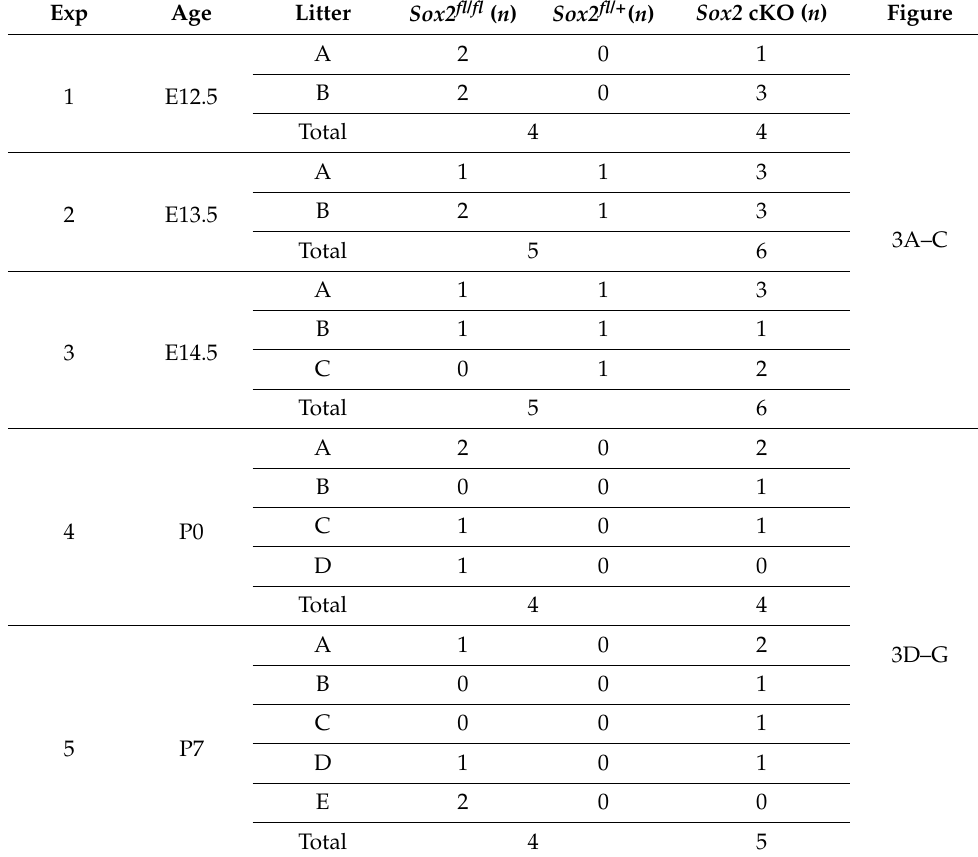
Table 1. Animals and litters used for BrdU assays and the corresponding representative figure. Exp Age Litter